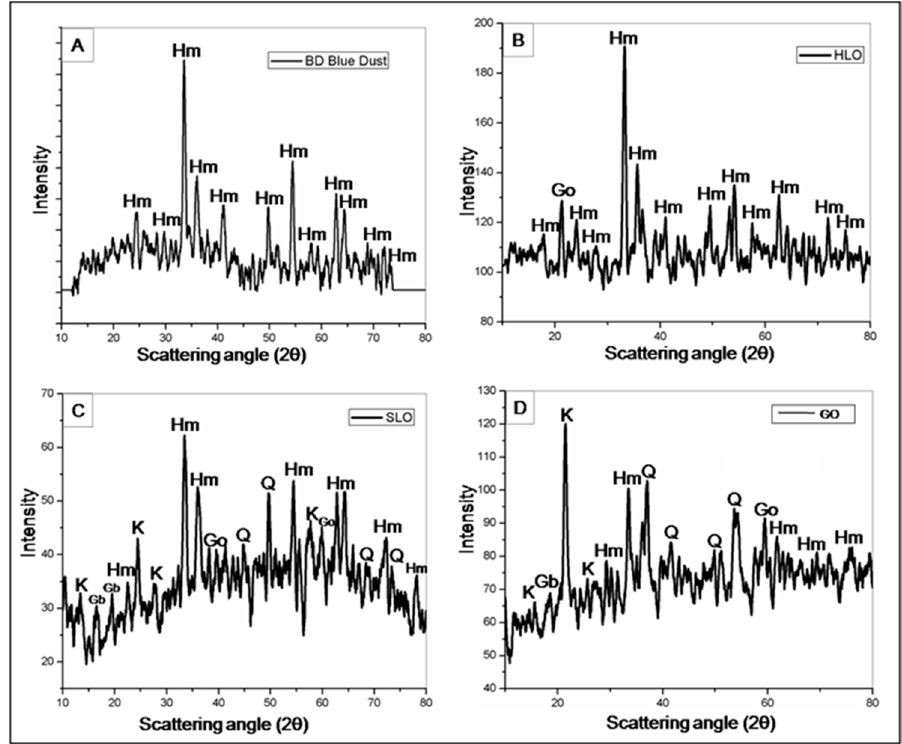
Figure 11. XRD patterns of iron ore samples from Kiriburu-Meghahatuburu iron ore deposit shows the presence of quartz (Q), kaolinite (K), gibbsite (Gb), hematite (Hm) and goethite (Go) in: ( A ) blue dust (BD 1); ( B ) hard laminated ore (HLO 1); ( C ) soft laminated ore (SLO2); and ( D ) goethitic ore (GO1).